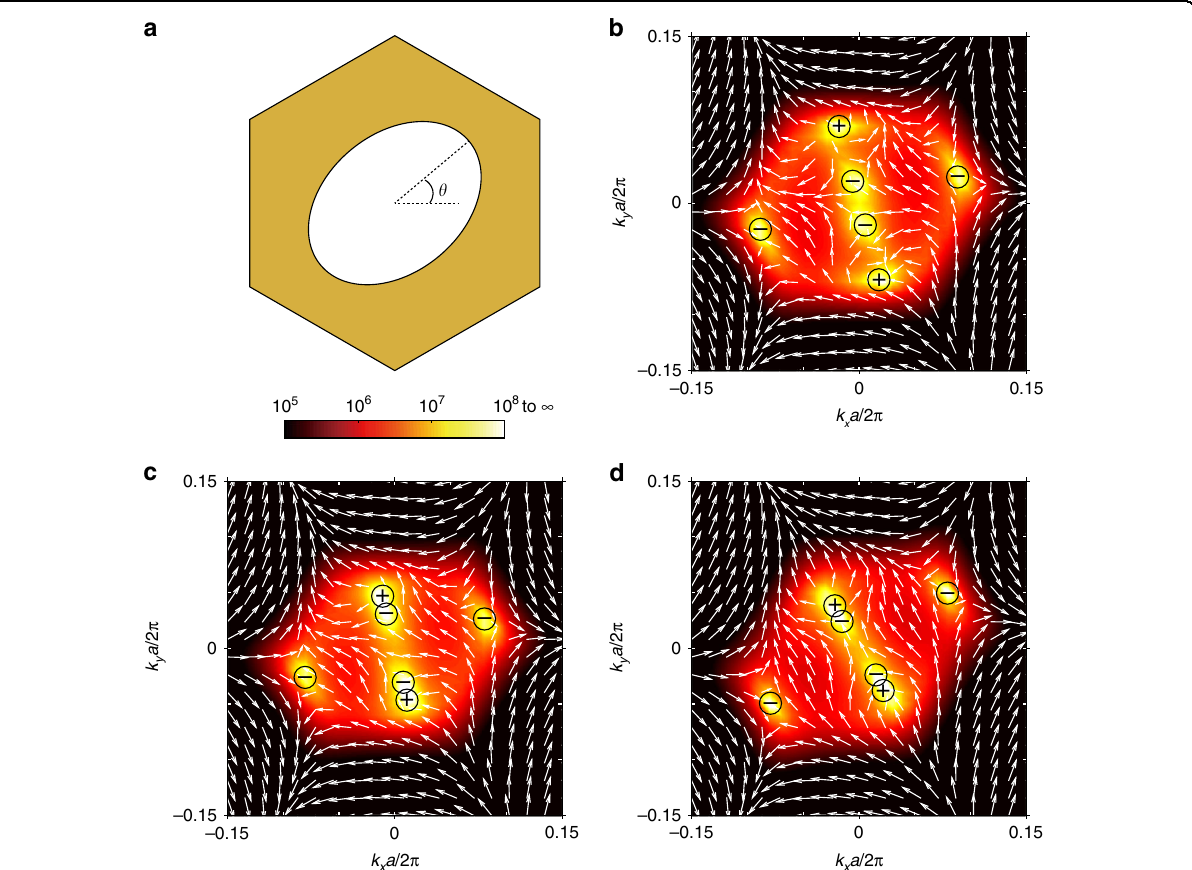
Fig. 4 Merging accidental BICs and split BICs at arbitrary k points. a The unit cell with elliptic cylindrical etched holes. Calculated distribution of polarization vectors with Q factors as background for b isolated BICs with θ = 10° and t = 338 nm, c merging BIC at ð(cid:4) 0 : 025 π = a ; ± 0 : 085 π = a Þ with θ = 10° and t = 334.7 nm, and d merging BIC at ð(cid:4) 0 : 045 π = a ; ± 0 : 07 π = a Þ with θ = 35° and t = 335.6 nm. In b-d , the lattice constant, semi-major axis and semi-minor are kept a t a = 336 nm, r 1 = 110 nm and r 2 = 80 nm, respectively. The materials used are the same as